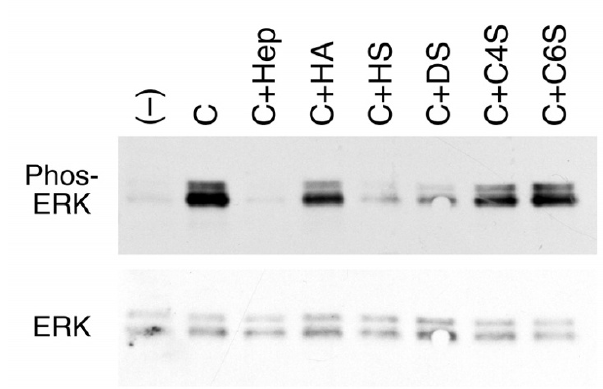
Figure 8 Inhibition of III1-C mediated ERK activation by heparitinase. RASMCs were collected in DMEM+0.5% BSA